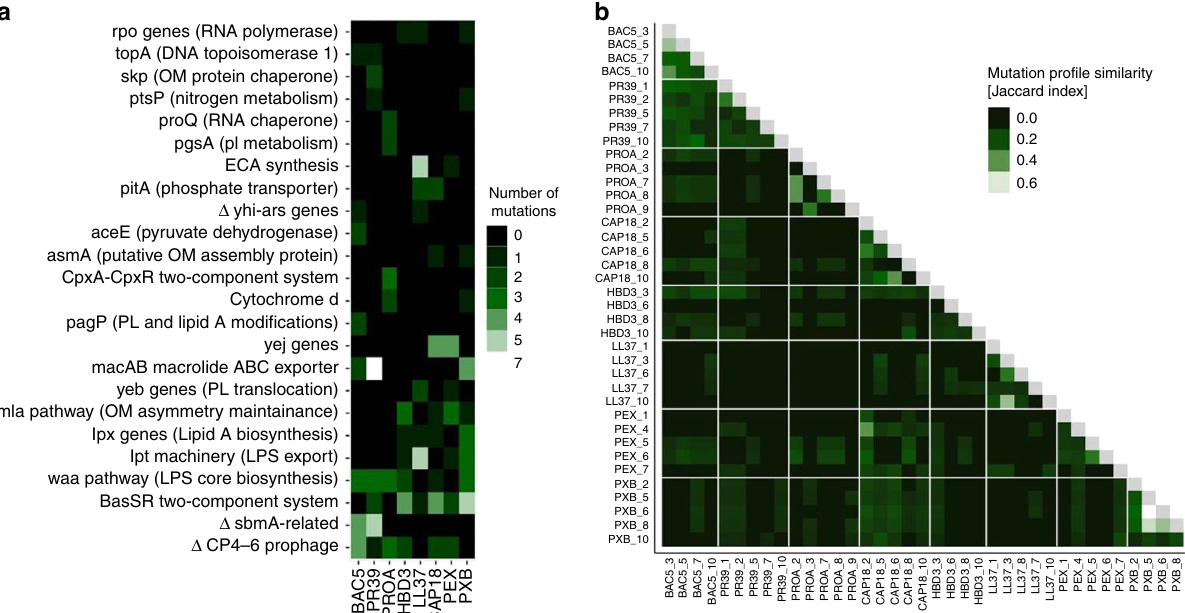
Fig. 4 Mutational pro fi les of 38 AMP-resistant lines. a The fi gure shows cellular complexes and pathways mutated independently in multiple lines as a function of AMPs used during laboratory evolution. The color code indicates the number of individual mutations affecting a given cellular subsystem in lines evolved to a given AMP. OM outer membrane, PL phospholipid, LPS lipopolysaccharide, Δ gene deletion. b Heatmap shows mutation pro fi le similarity of AMP-resistant lines. Mutation pro fi le similarity between each pair of AMP-resistant lines was estimated by the Jaccard ’ s coef fi cient between their set of mutated genes. Large deletions were counted as one gene. AMP-resistant lines are named after the AMP it has been exposed to during the evolutionary experiment, and the serial number of the corresponding population. For AMP abbreviations, see Supplementary Table